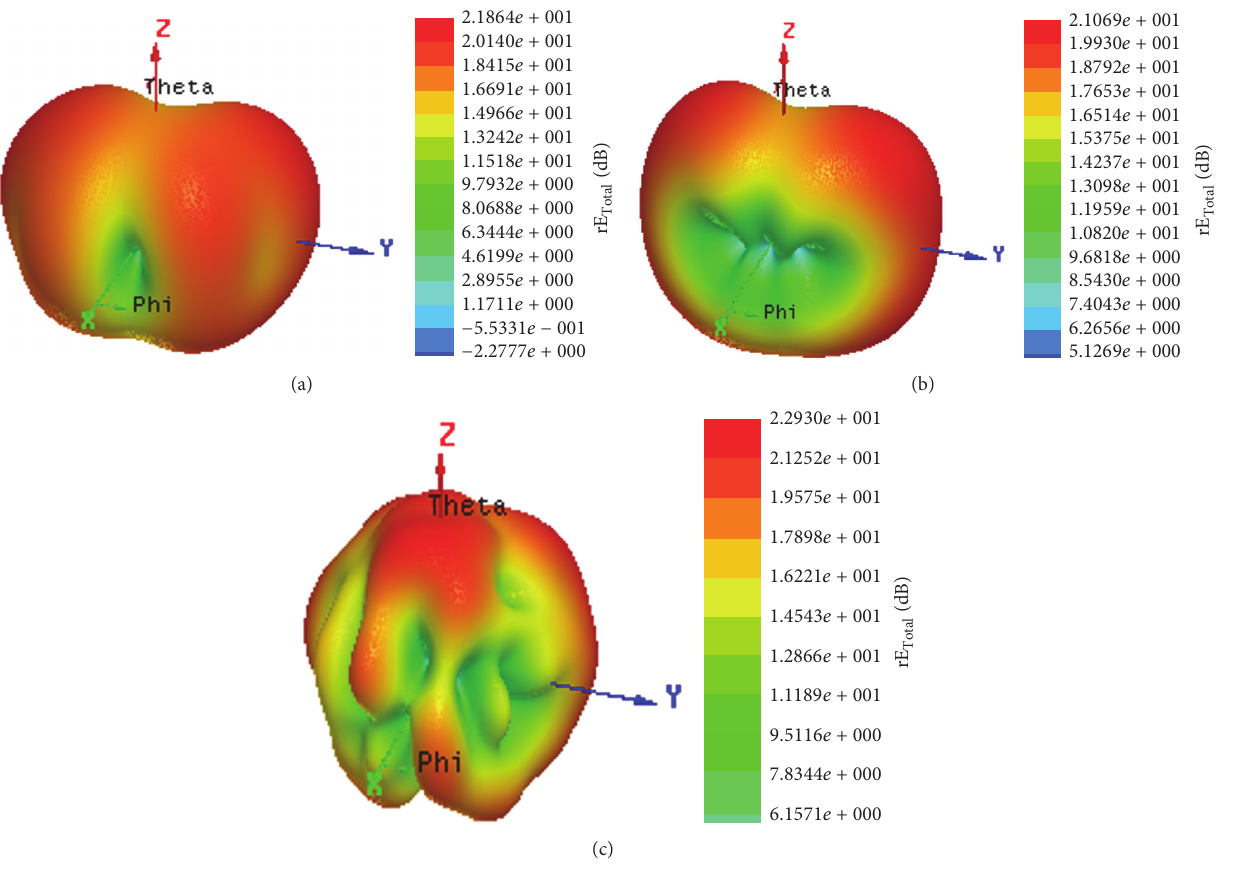
Figure 15: 3D polar plot at various frequencies of proposed defected substrate wideband antenna: (a) 5.48 GHz, (b) 8.03 GHz, and (c) 12.01GHz.